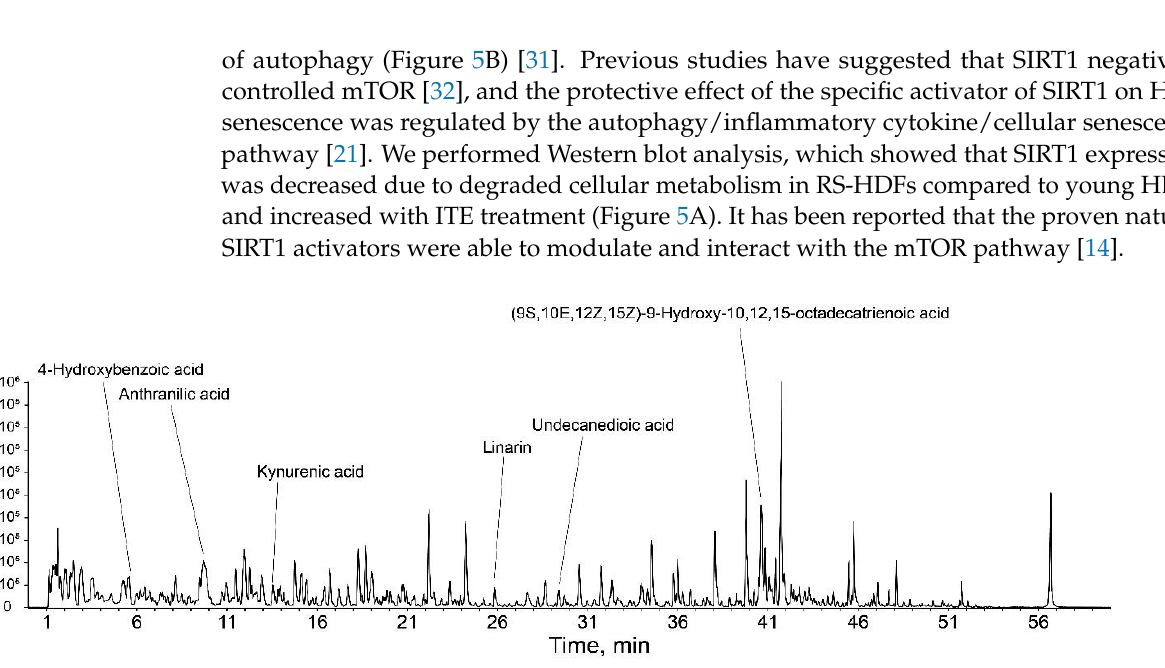
Figure 6. Base peak chromatogram (BPC) of the total ion chromatogram (TIC) of ITE.